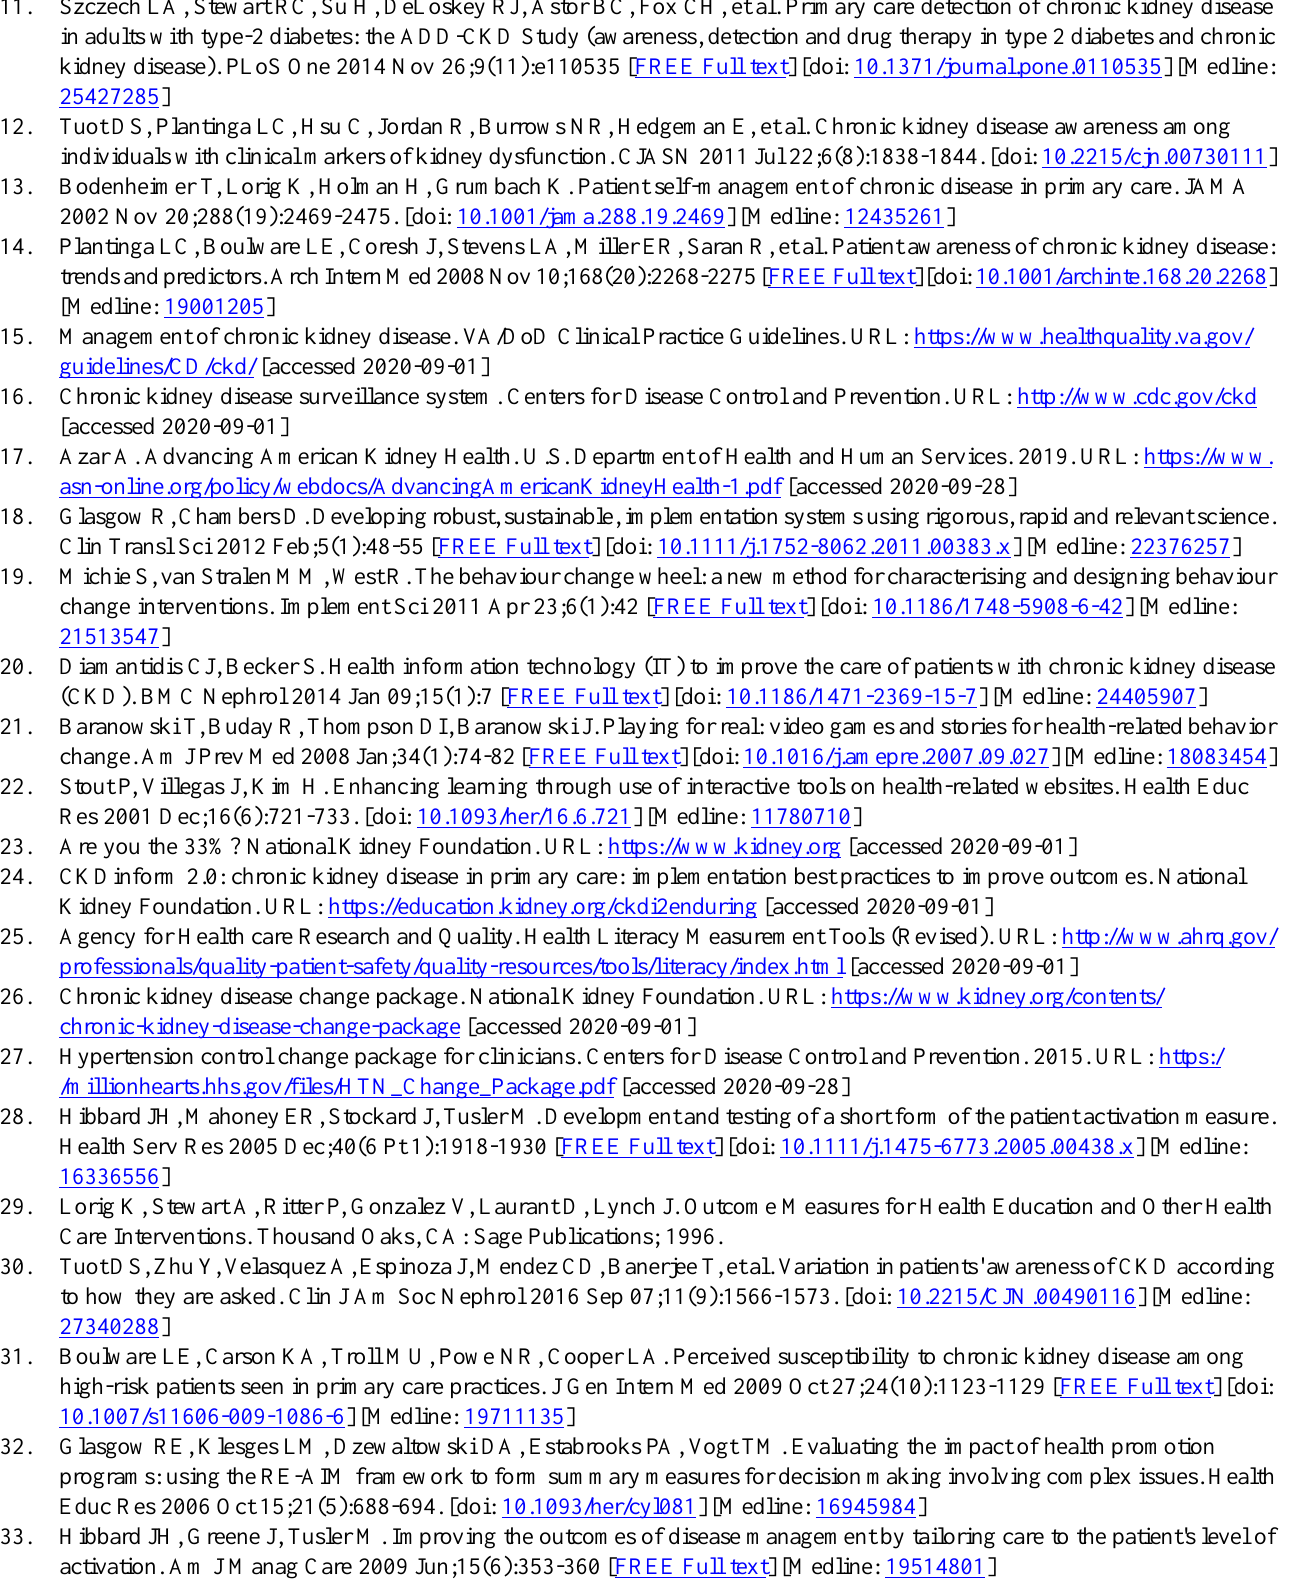
COM-B: capability, opportunity, motiviation – behavior NKF: National Kidney Foundation PACT: Patient Aligned Care